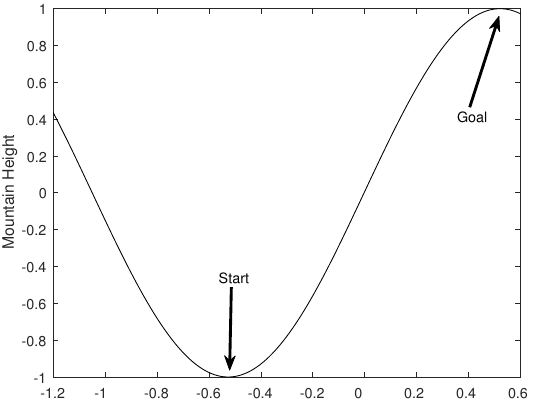
Figure 6. The mountain car environment. The purpose of the agent is to start from the starting position marked "Start", and use the energy obtained by sliding down from the left side of the mountain to rush to the position marked "Goal" on the right side of the